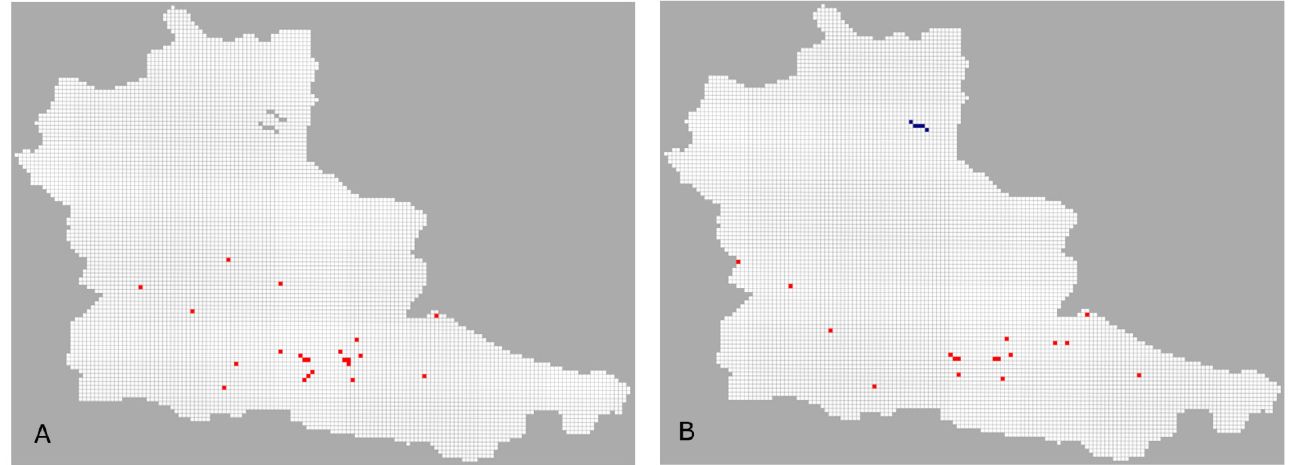
Figure 8. Location of production wells (red cells) within the 3rd ( A ) and 4th ( B ) model